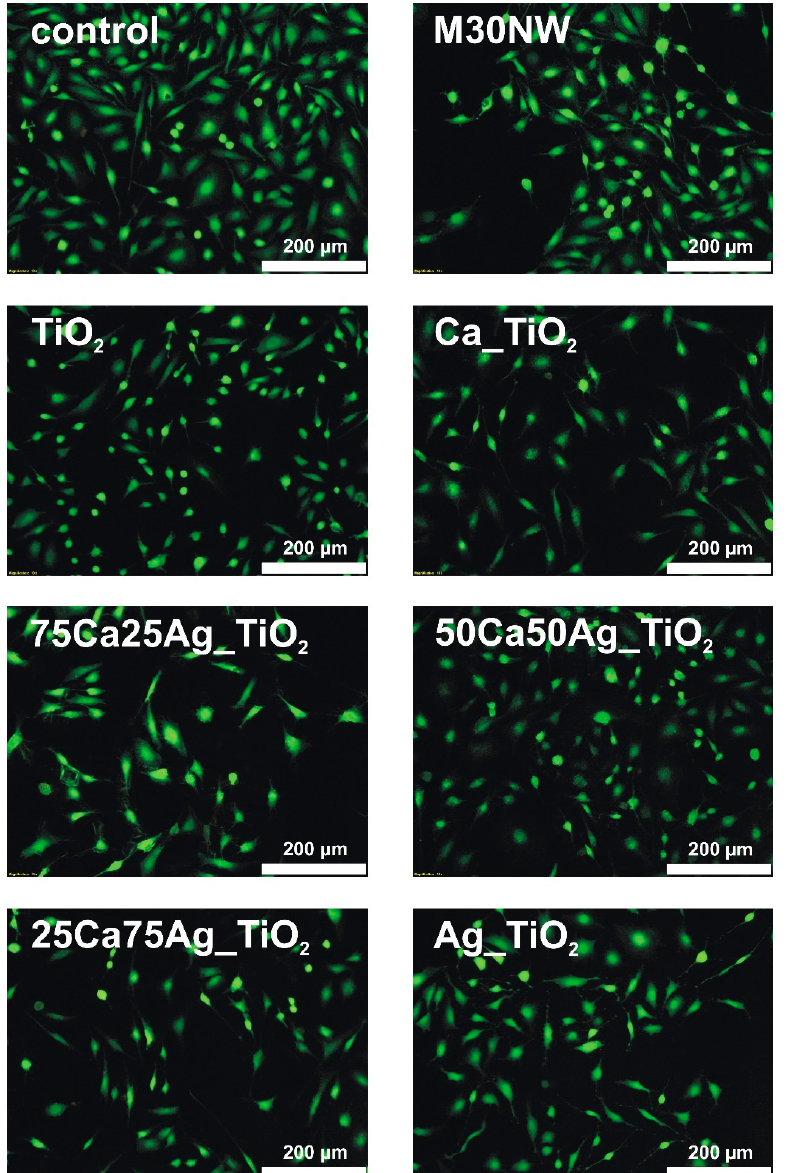
Figure 10. The osteoblast cells images (fluorescent stained, live cells—green colour, bar 200 µ m) after 48 h of growing on samples (direct contact) modified by coatings with different composition and nanostructure.